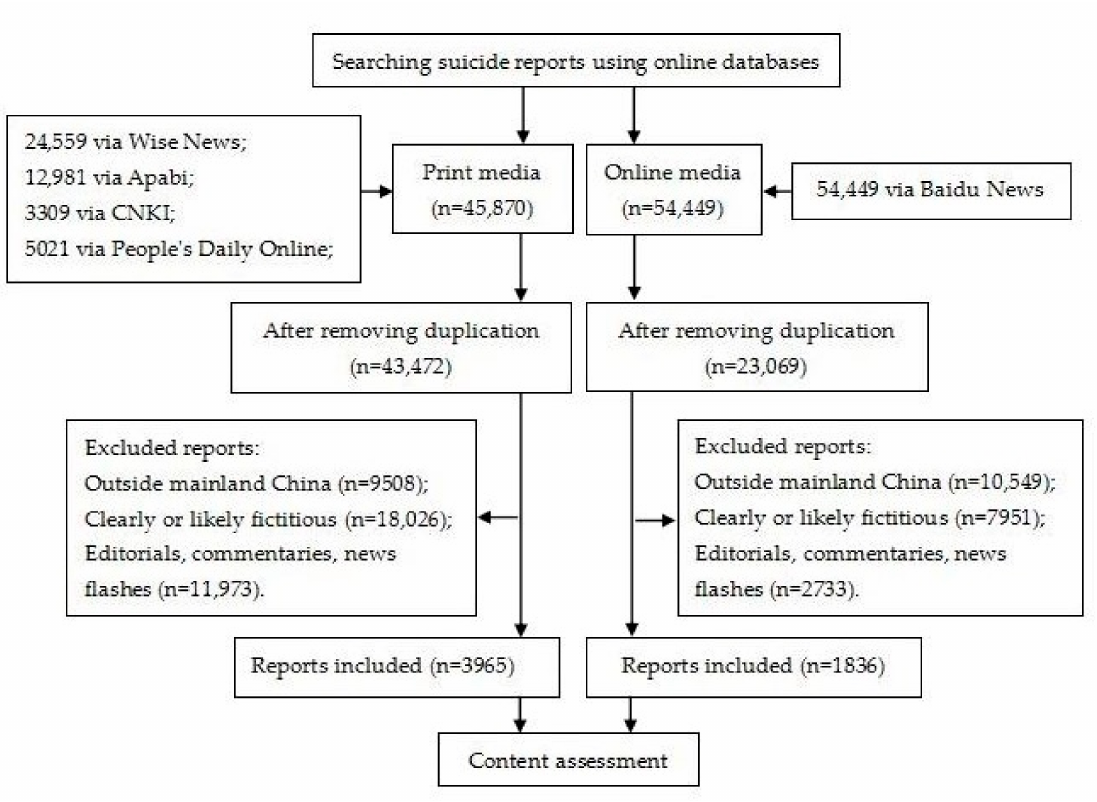
Figure 1. Selection process of media suicide